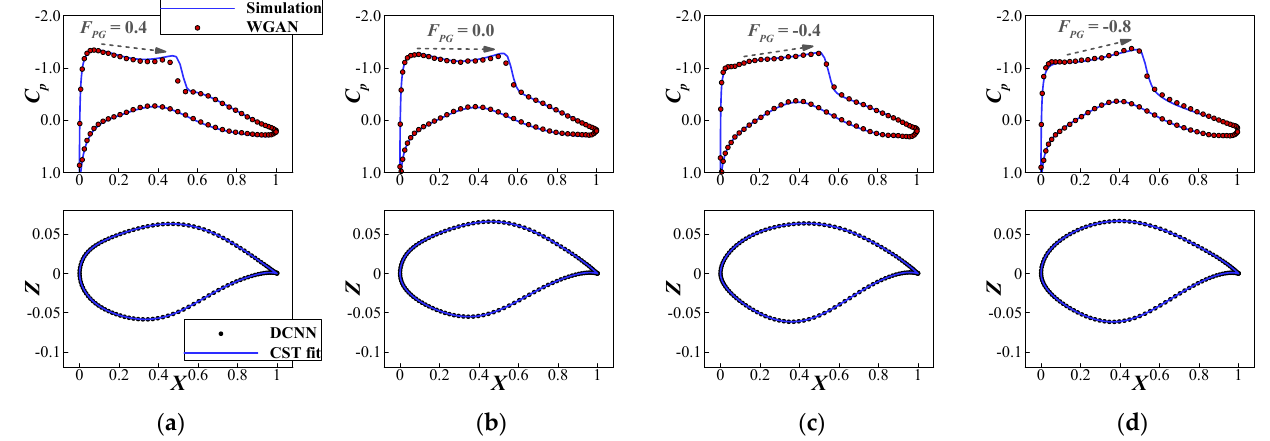
Figure 14. Typical inverse design results produced by different pressure gradient features: ( a ) F PG = 0.4; ( b ) F PG = 0.0; ( c ) F PG = − 0.4; ( d ) F PG = −